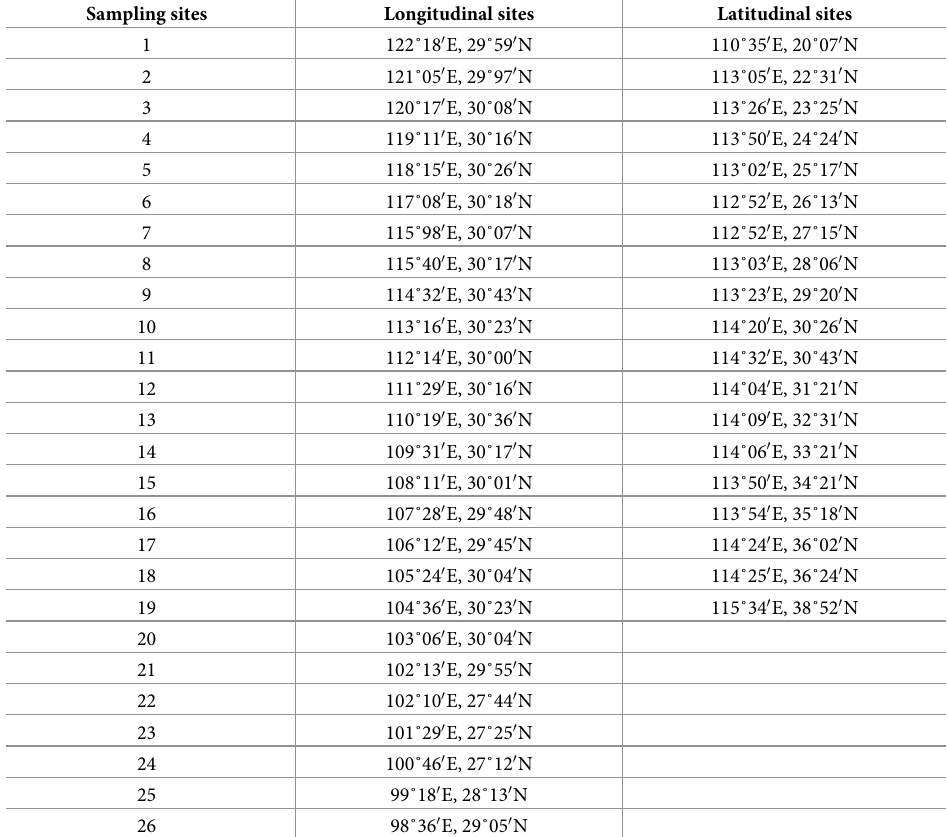
Table 1. The sample sites of A . philoxeroides along the latitudinal and longitudinal gradients in China. The oldest community of A . philoxeroides is in Shanghai city [23]. Sampling sites Longitudinal